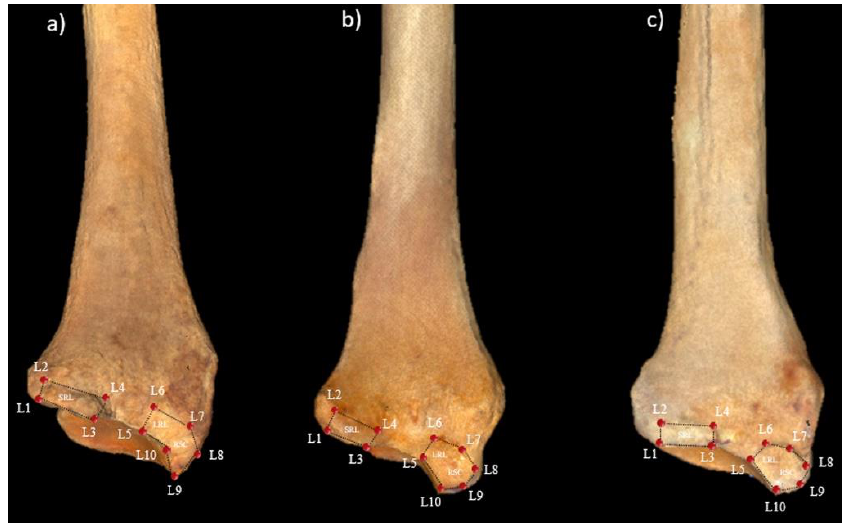
Figure 1. Distal radial epiphyses of ( a ) Gorilla gorilla , ( b ) Pan troglodytes , and ( c ) Pongo pygmaeus . In each of the distal radial epiphyses, the insertion sites of the palmar radiocarpal ligaments are shown with the locations of the landmarks.